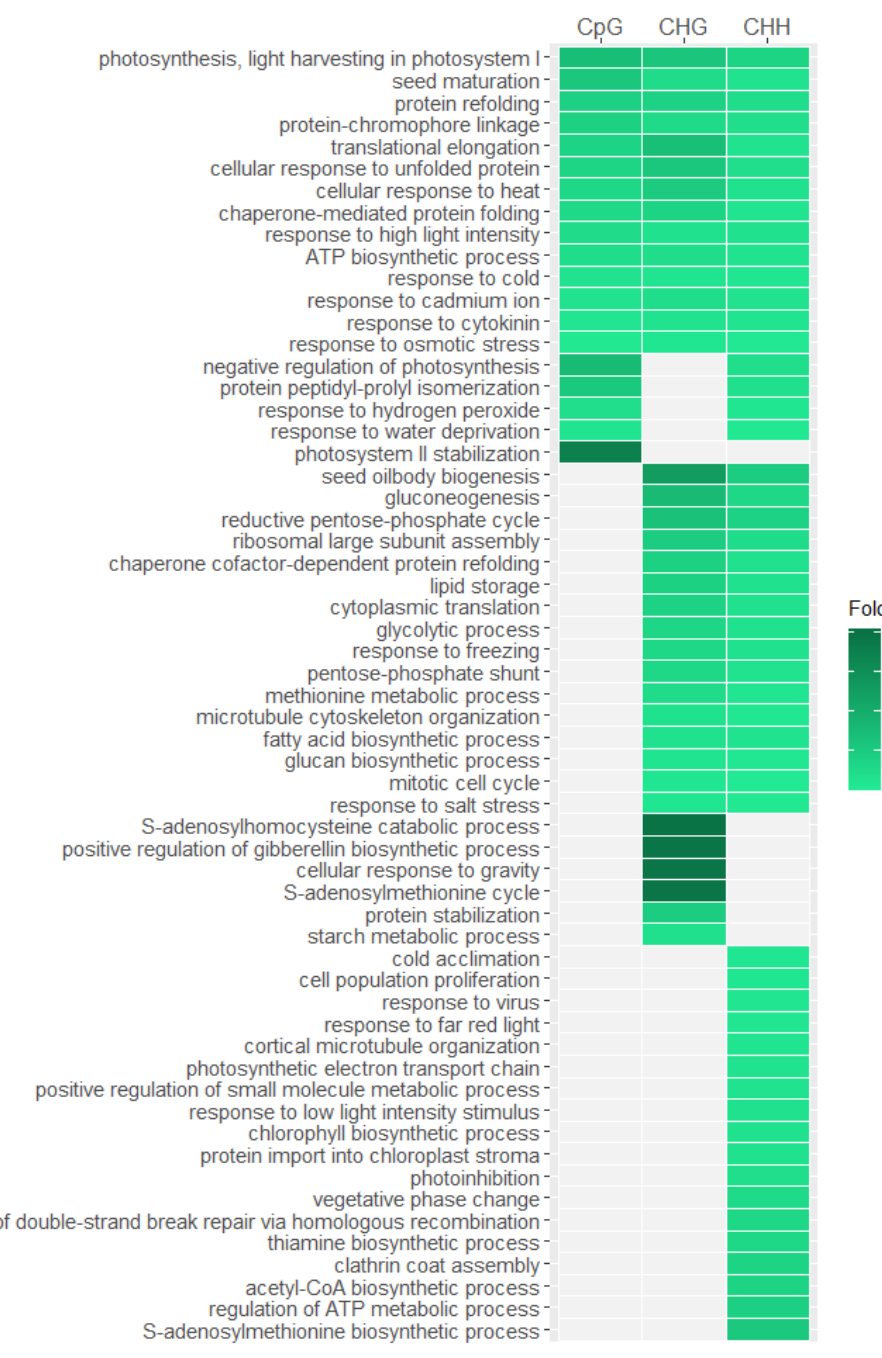
Figure 6. Biological processes overrepresented in differentially methylated Arabidopsis thaliana genes in different sequence contexts (CpG, CHG, CHH). Only the most significant processes from the gene ontology hierarchy tree are presented.